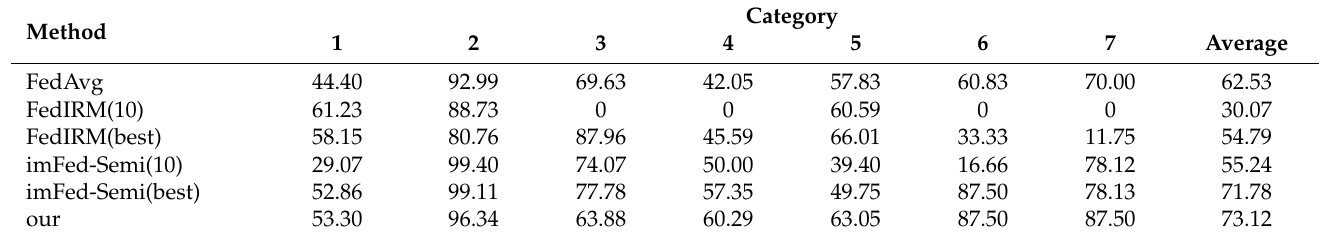
Table 2. Comparison of the sensitivity of each category under different